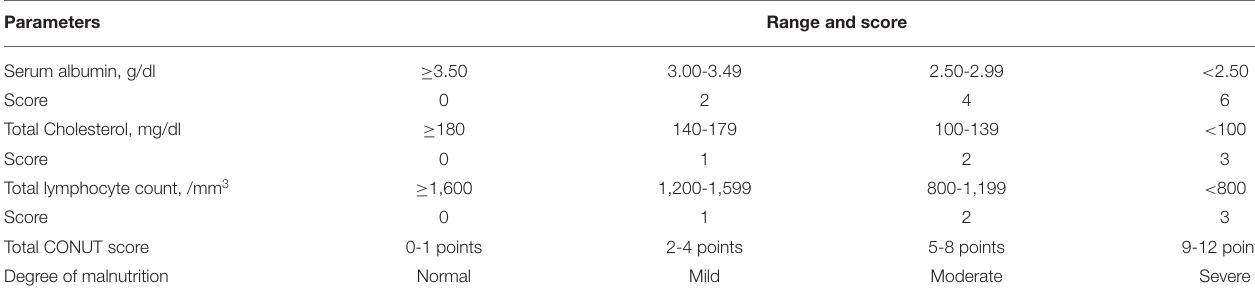
TABLE 1 | Definition of CONUT